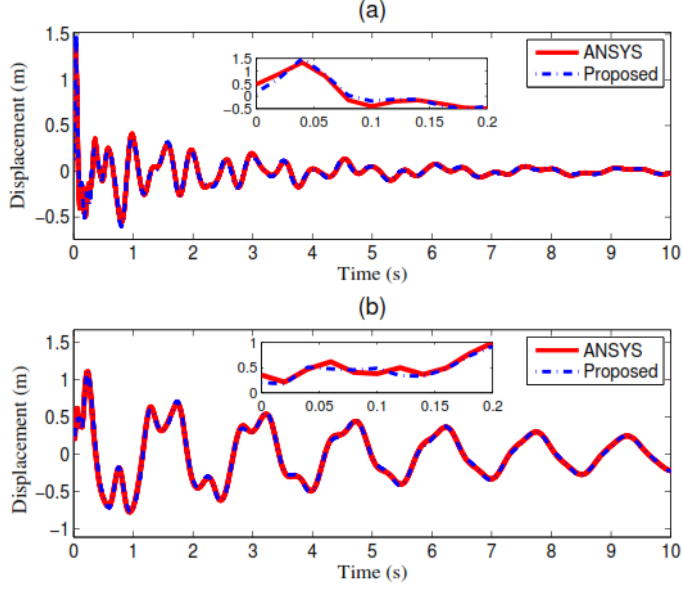
Figure 13. The response comparisons with ANSYS at nodes 28 and 50 in the x direction: ( a ) node 28 and ( b ) node 50 using random initial conditions.